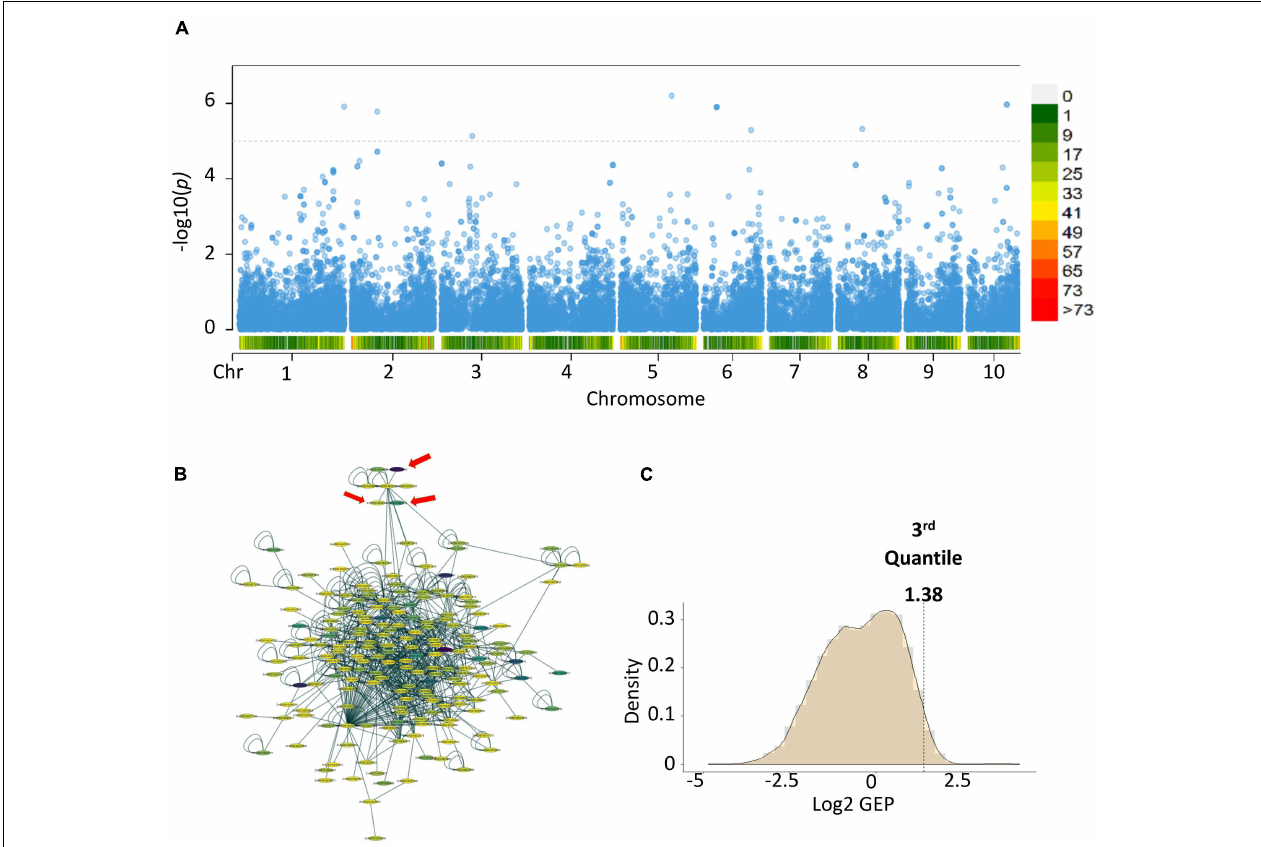
FIGURE 2 | Post-GWAS results of aflatoxin accumulation generated using Warburton et al. (2015) data and KSA gene expression data. (A) Meta-analysis of the MAGMA results from the College Station, Lubbock and Starkville results. (B) Subnetworks with the highest score from the top 100 modules created by using dense module network search (EW_dmGWAS) in R. (C) Density plot of the gene expression plasticity data from the rlog counts of the RNA-seq data. In the Manhattan plot, the horizontal dotted lines are the thresholds for significant log 10 p -value/Number of markers), below chromosome labels on the x -axis is the gene density in the chromosomal location. In the network, color represents the gene expression plasticity values.